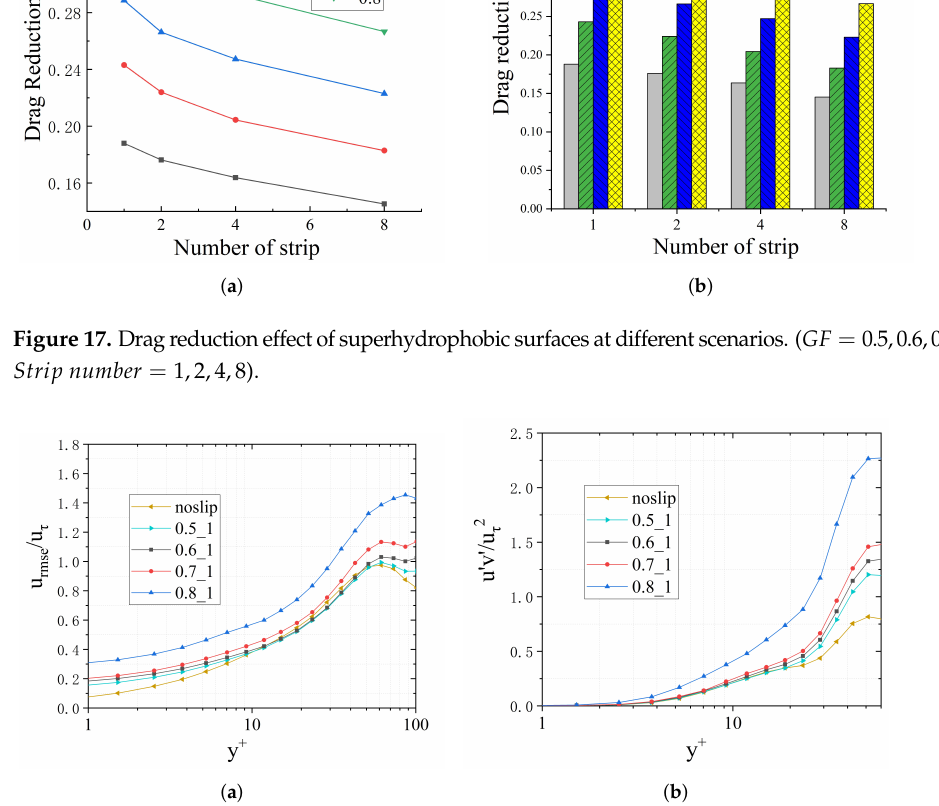
Figure 18. Caparison of statistics for Strip number = 1 at different GF. ( a ) Velocity RMSE. ( b ) Reynolds number. Figure 19 is the noise level under different GF when the number of strips is